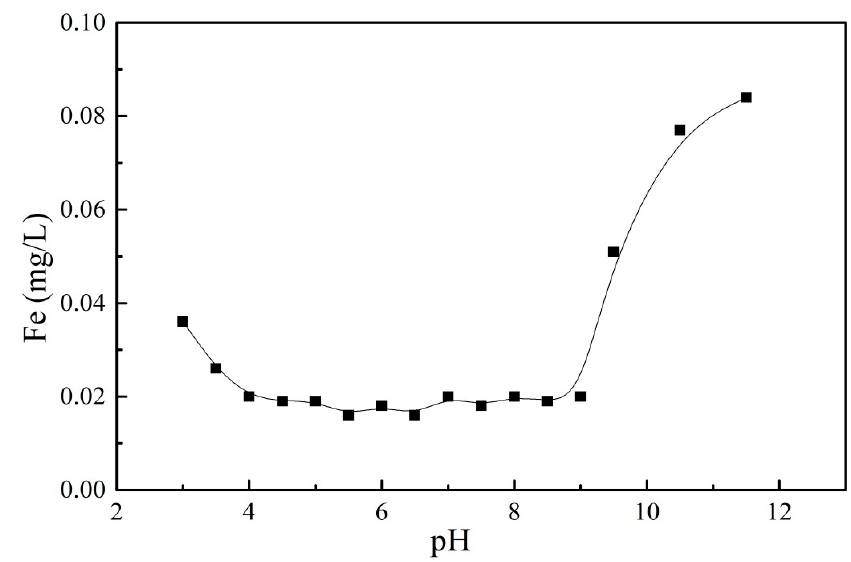
/ Fe ff erent pH levels. 3 O 4 at di